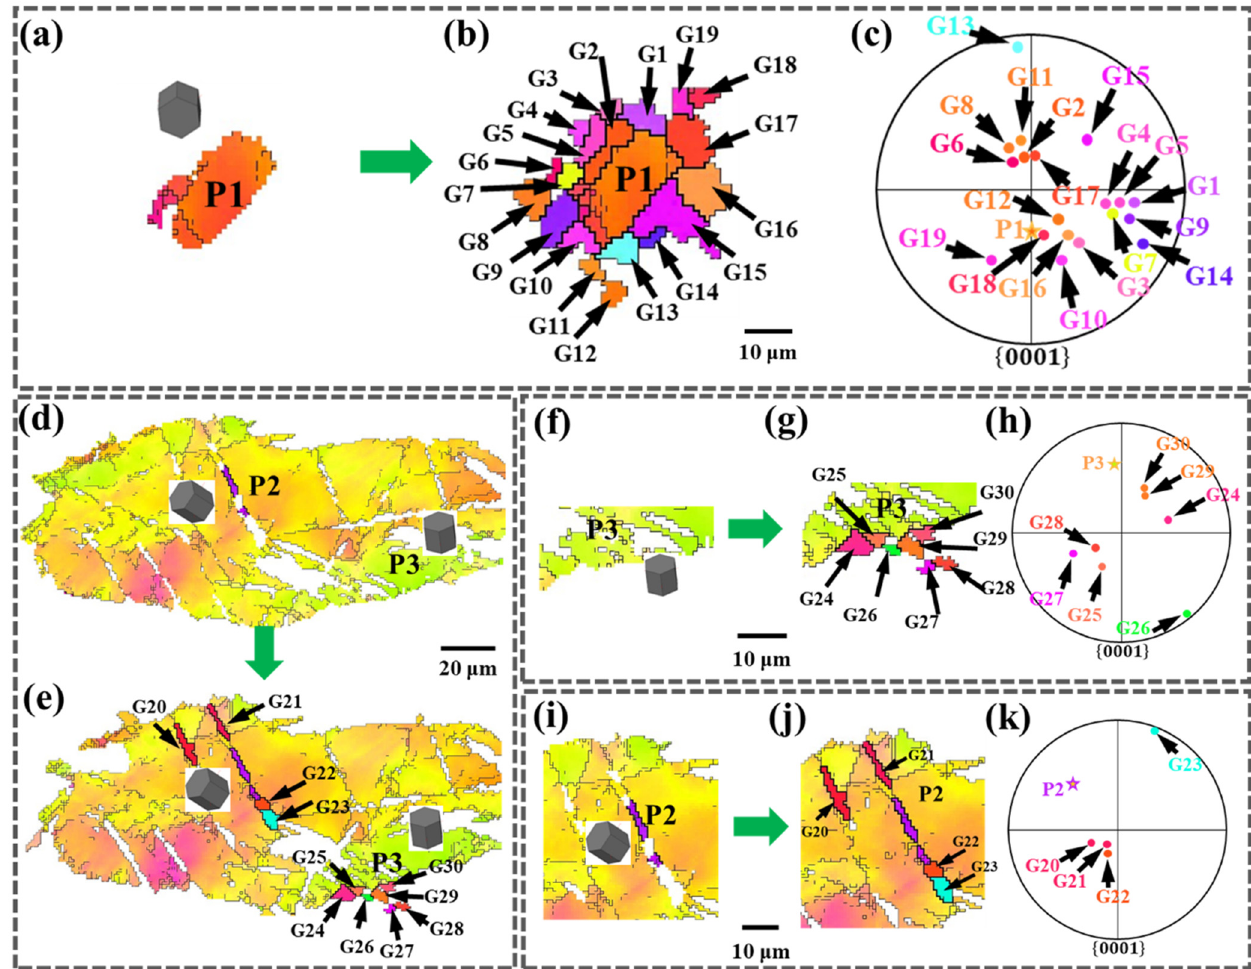
Figure 4. Microstructure evolution of different regions of as-rolled magnesium alloy during quasi- in situ heating: ( a , d , f , i ) 0 min, ( b , e , g , j ) 30 min, ( c , h , k ) {0001}pole figure.